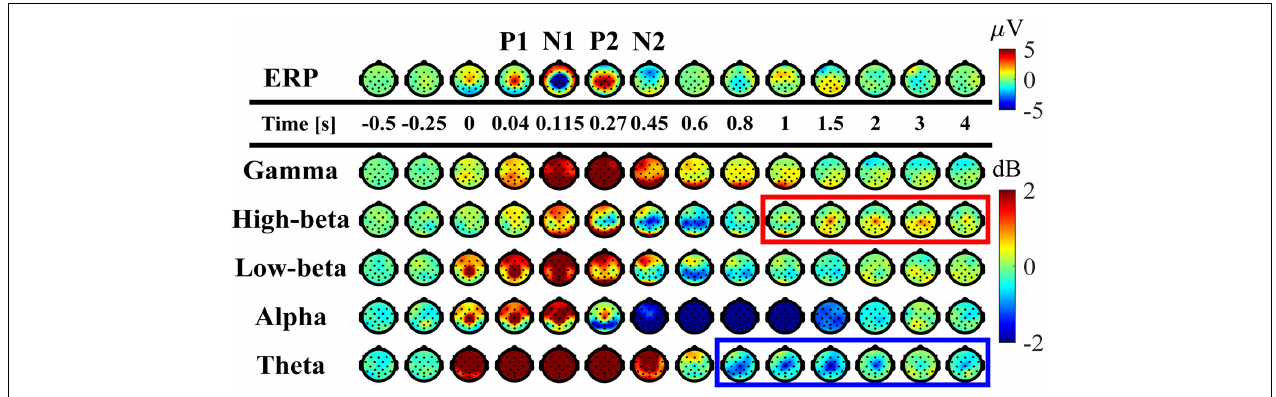
FIGURE 5 | Spatial distributions of ERP and ERSP on the scalp (averaged across participants). Upper panel: time-changes in the spatial distribution of the potential on the scalp. Lower panels: time-changes in the spatial distribution of EEG-power, i.e., ERSP, for the frequency-bands of theta (4–7 Hz), alpha (8–13 Hz), low-beta (13–20 Hz), high-beta (21–30 Hz), gamma (40–60 Hz) plotted on the scalp. The scalps surrounded by the red and blue rectangles indicate that beta ERS whose amplitude was significantly larger than the mean power before perturbation and theta ERD which were significantly smaller, respectively, at the Cz